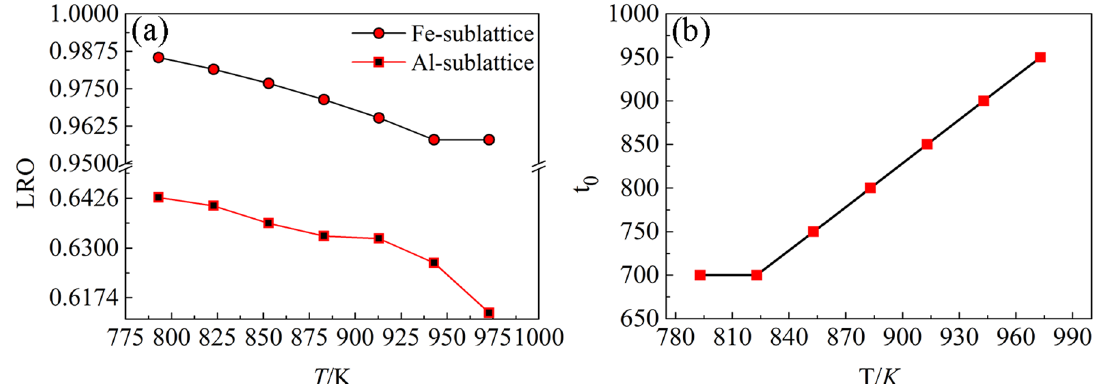
Figure 5. (a) Change of LRO degree under the influence of various temperatures for Fe-35 at. % Al alloy. (b) The starting times of ordering at different temperatures. T = 793, 823, 853, 883, 913, 943, 973